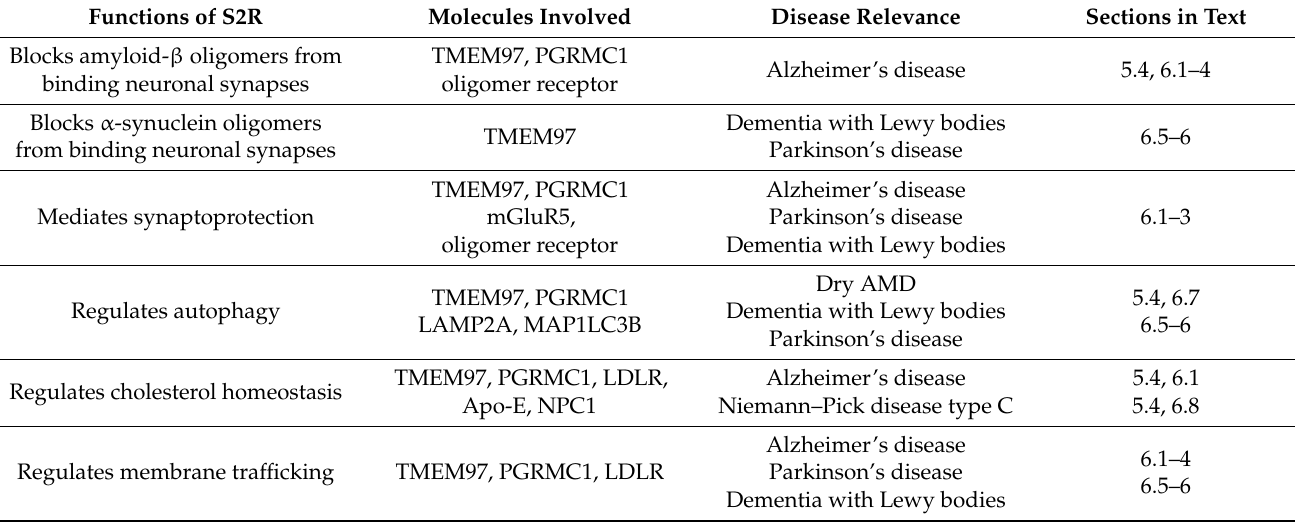
Figure 3. Structure–function of S2R and role of S2R small molecule modulators in restoring cell health and function. The amyloid- β oligomer receptor is a protein complex (light blue) that binds amyloid- β oligomers and is comprised of cellular prion protein (PrP c ) along with other proteins including leukocyte immunoglobulin-like receptor subfamily B2/paired immunoglobulin-like type 2 receptor B (LilrB2), and possibly also Nogo-66 receptor 1 (Nogo). S2R small molecule modulator (green) binds to the S2R (TMEM97; purple). Abbreviations: AMD, age-related macular degeneration; A β , amyloid- β ; PGRMC1, progesterone receptor membrane component 1; RPE, retinal pigment epithelium; S2R, sigma-2 receptor; TMEM97, transmembrane protein 97. Table 1. Key functional roles of S2R and the molecular players